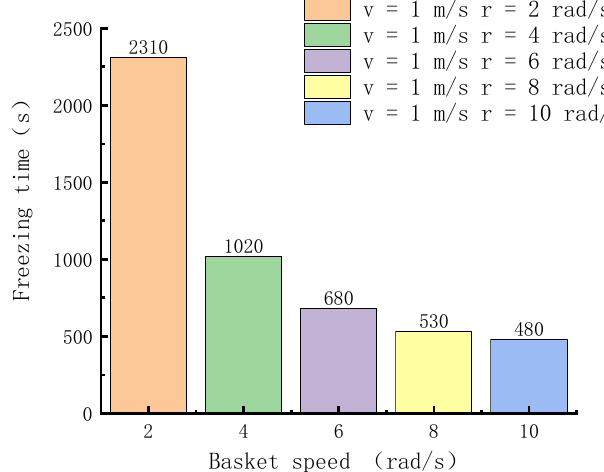
Figure 11. Histogram of load frame speed and freezing time.